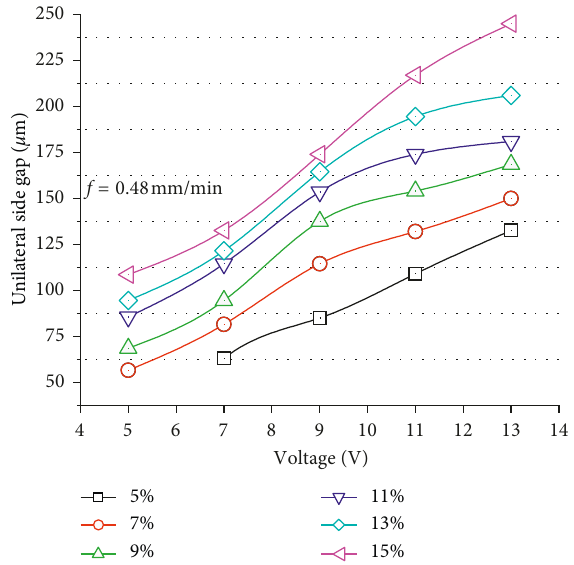
Figure 4: Variation curves of the unilateral side gap with the voltage.